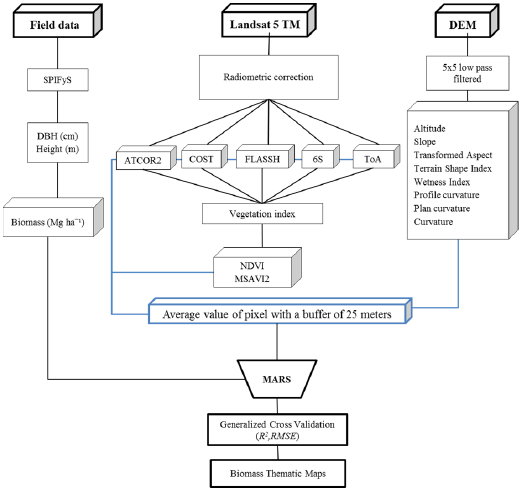
Figure 2. Flow diagram of the processes involved in estimating AGB.